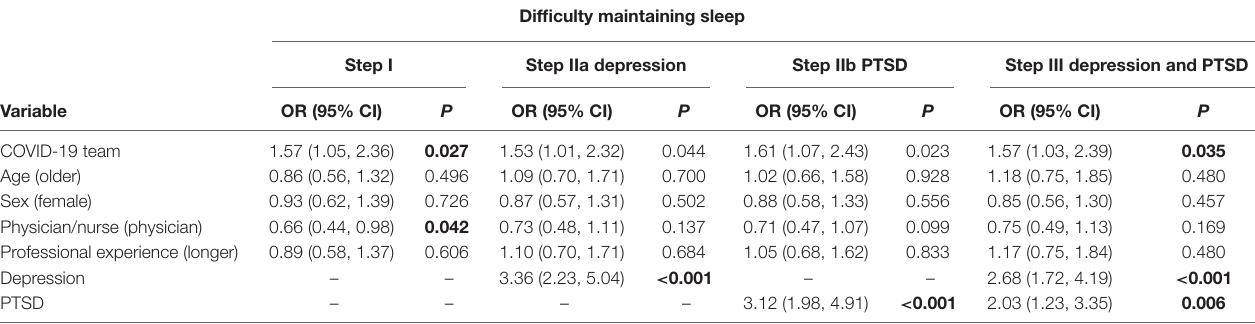
TABLE 4 | The association between difficulty maintaining sleep and PTSD and depression in COVID-19 and non-COVID- 19 healthcare workers. Difficulty maintaining sleep Step I Step IIa depression Step IIb PTSD Step III depression and